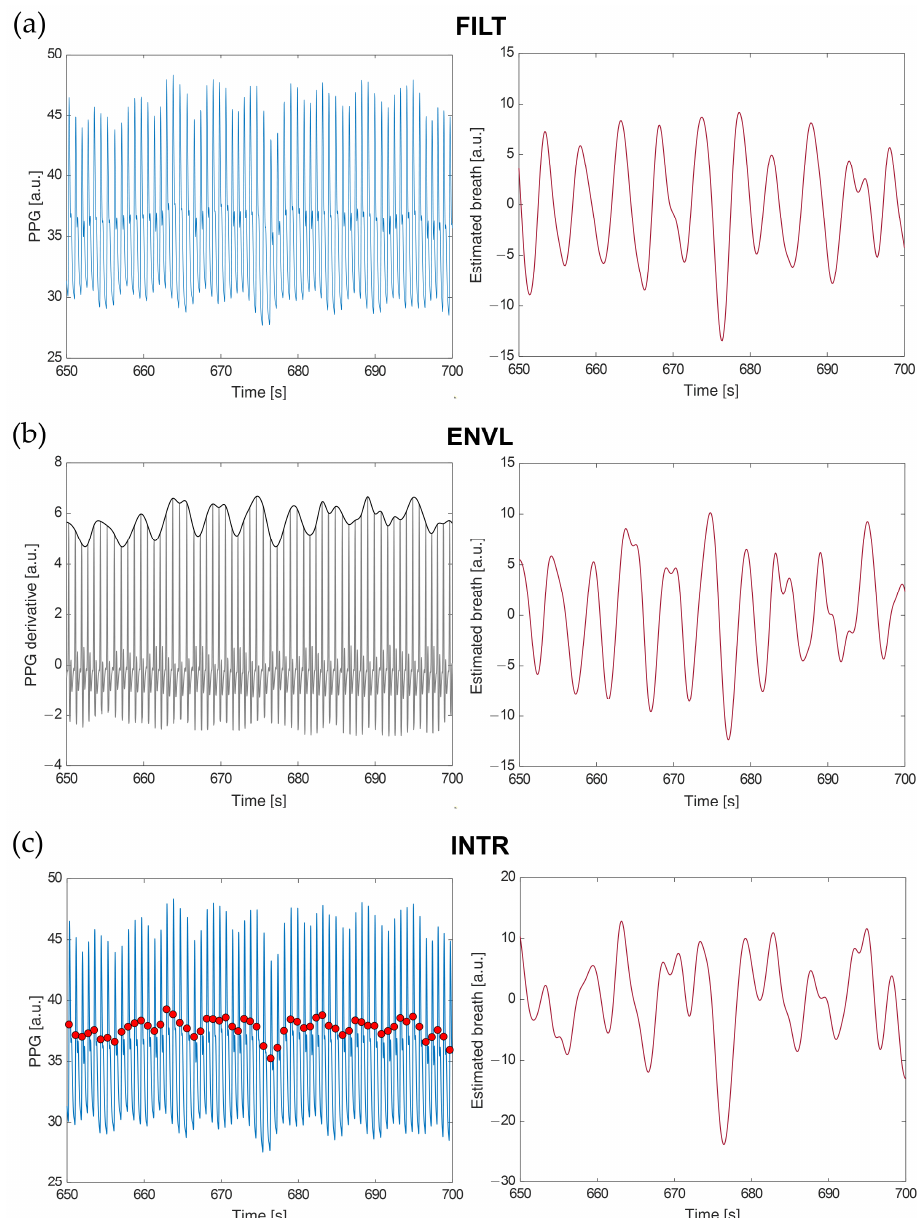
Figure 3. Application of the FILT ( a ), ENVL ( b ), and INTR ( c ) methods to the respective signals of interest. On the first column, input signals and main features are: ( a ) PPG signal (light blue); ( b ) derivative of the PPG signal (grey) and relative superior envelope (black); ( c ) PPG signal (light blue) and points of maximum slope (red). Second column: breath signals obtained with each method.